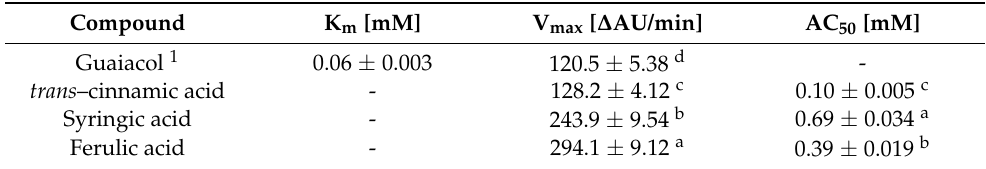
Table 1. K m , V max and AC 50 values of the chosen phenolic acids on thyroid peroxidase (TPO) activity, n = 9.